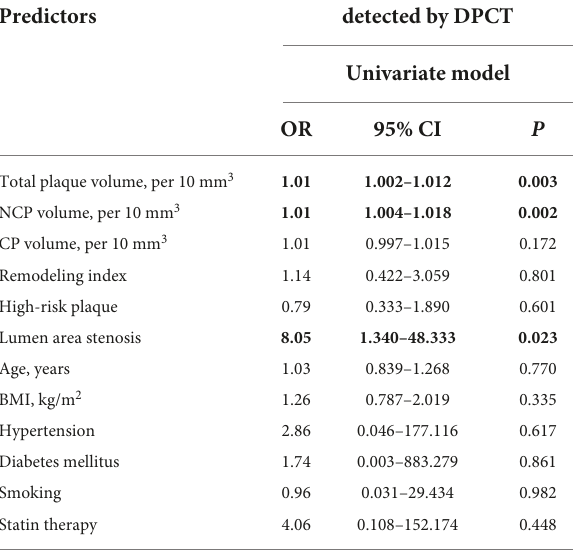
TABLE 4 Univariate logistic regression analysis of the predictors of myocardial ischemia detected by DPCT. Myocardial